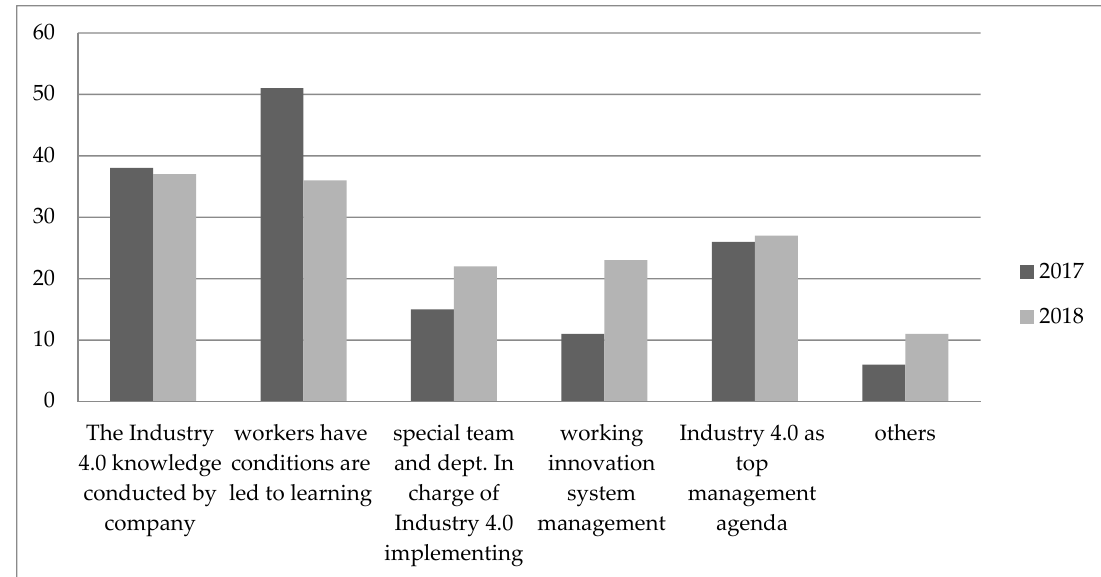
Figure 4. The motivation to apply Industry 4.0 witnin the internal corporate culture in %. Source: own processing based on survey results.